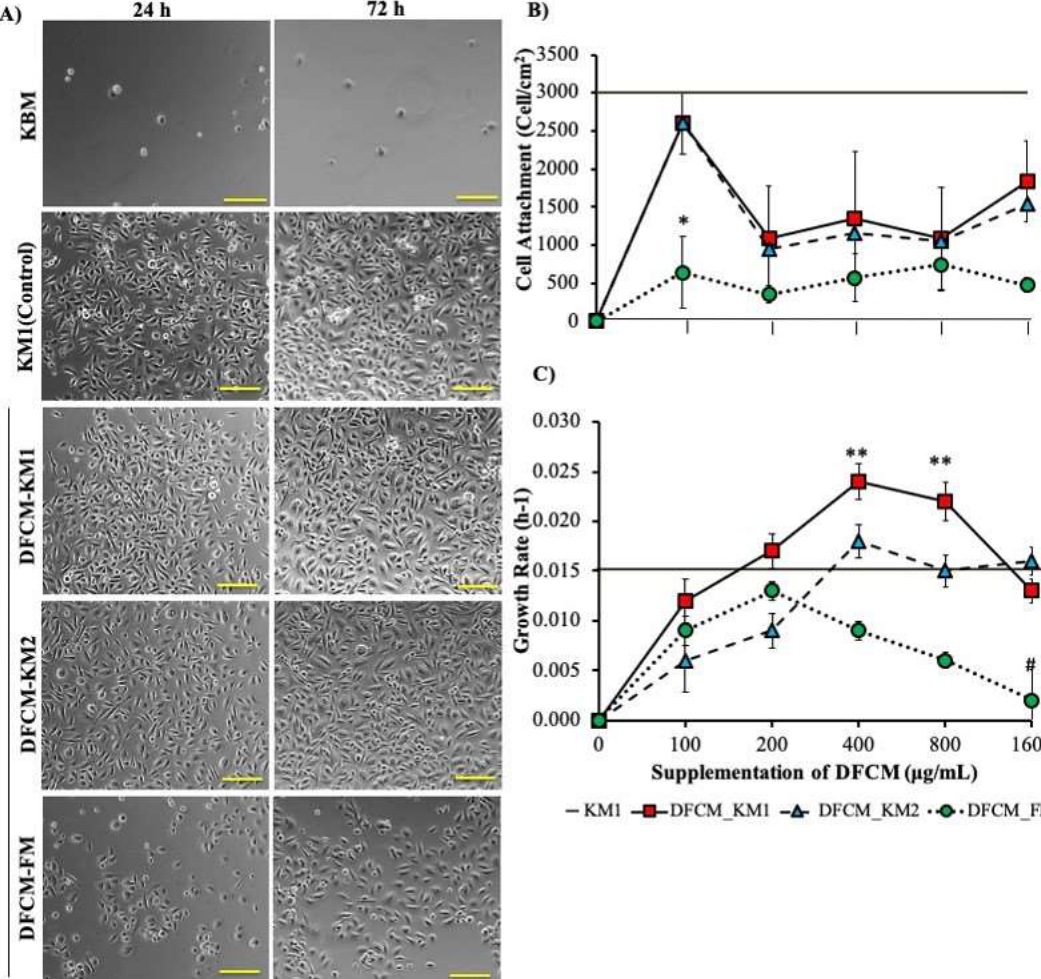
Figure 1. The e ff ect of dermal fibroblast conditioned medium (DFCM) on keratinocyte attachment Figure 1. The effect of dermal fibroblast conditioned medium (DFCM) on keratinocyte attachment